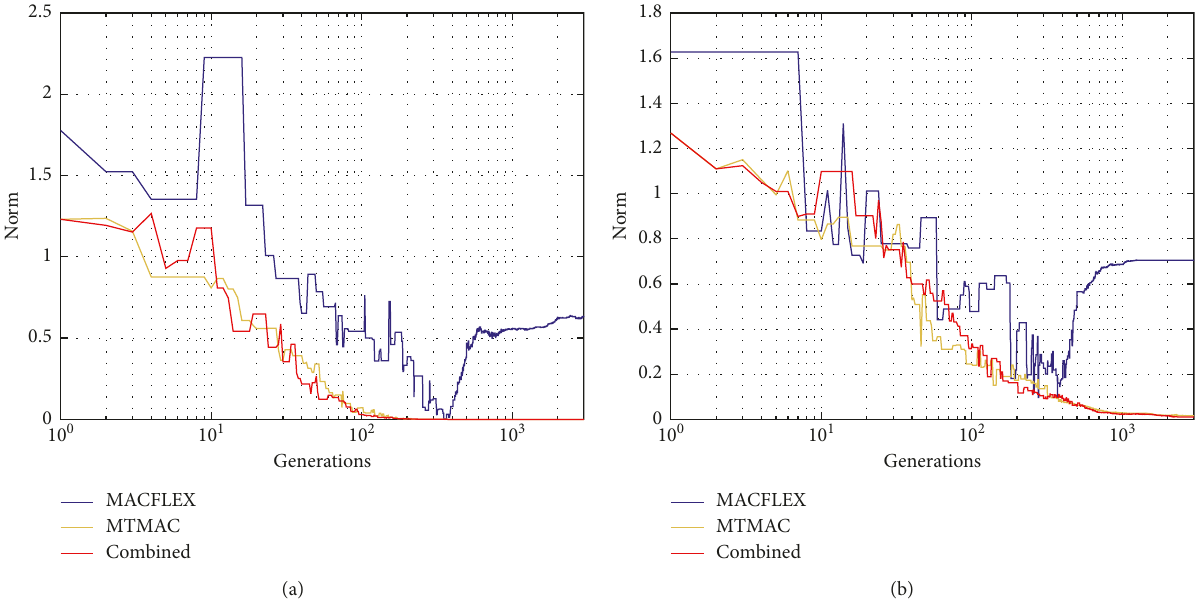
Figure 5: Beam example: norm values for the three objective functions versus generations, for three known eigenmodes, for damage scenarios 2 and 3 (no noise). (a) Scenario 2 and (b) scenario 3.